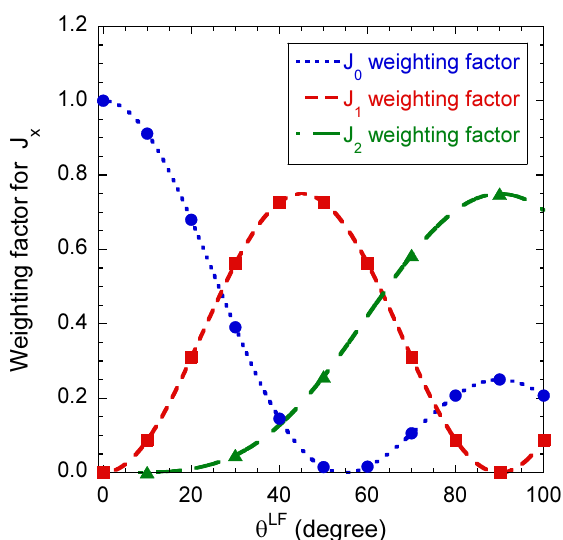
Figure 7. Angular variations of the relative weights of the various intrinsic contributions J X , intr m ( ω ) to the m = 0 component of the apparent spectral density J X relaxation mechanisms (see Equation (A16a) in the Appendix B).